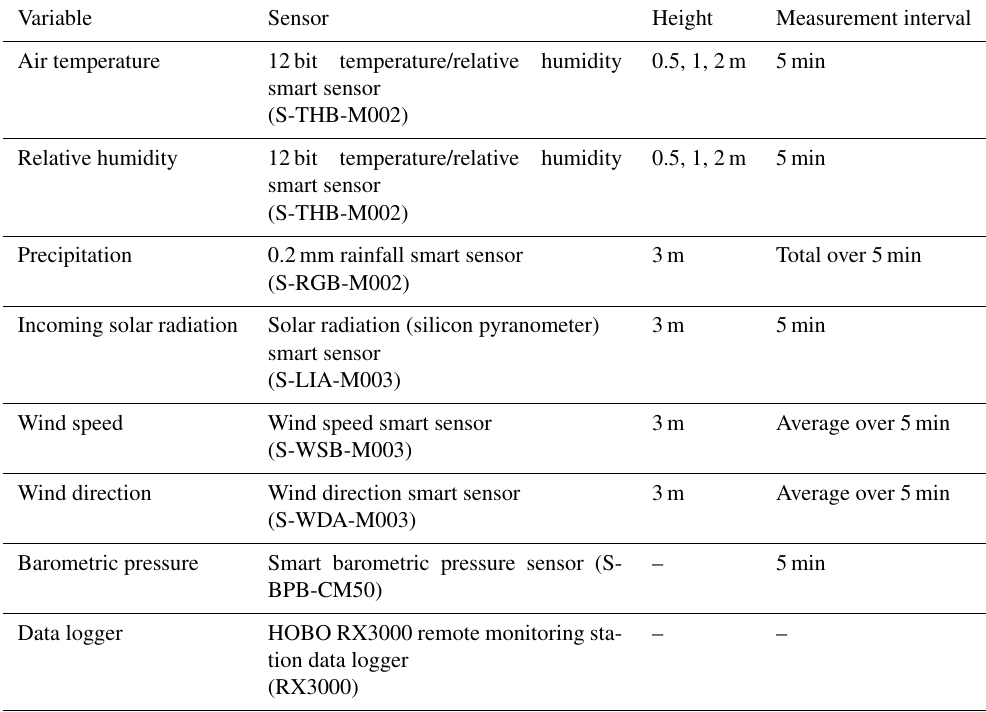
Table B1. Sensors of the HOBO RX 3000 remote weather station that was used during the field season of